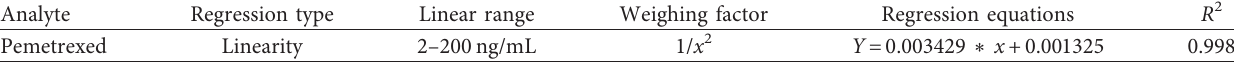
Table 2: Linearity regression parameters of pemetrexed.